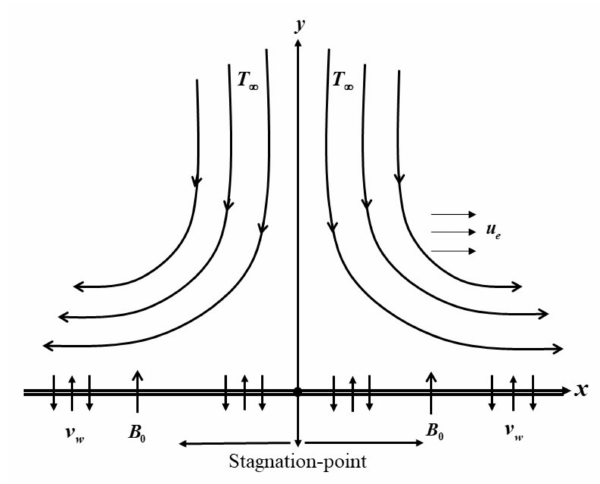
Figure 1. Illustration of the problem